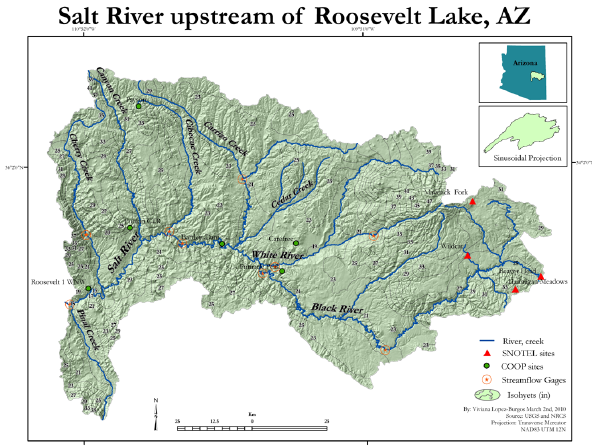
Fig. 1. The upper Salt River